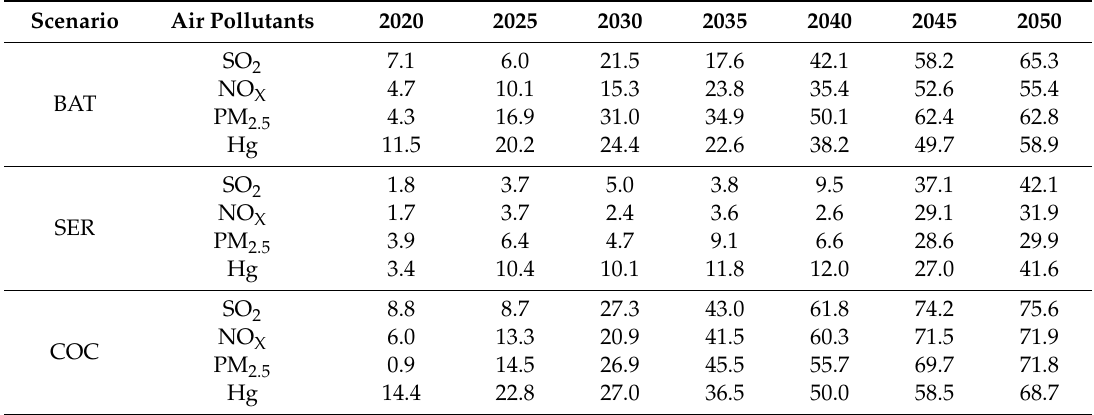
Table 5. Emission reduction rate in power industry